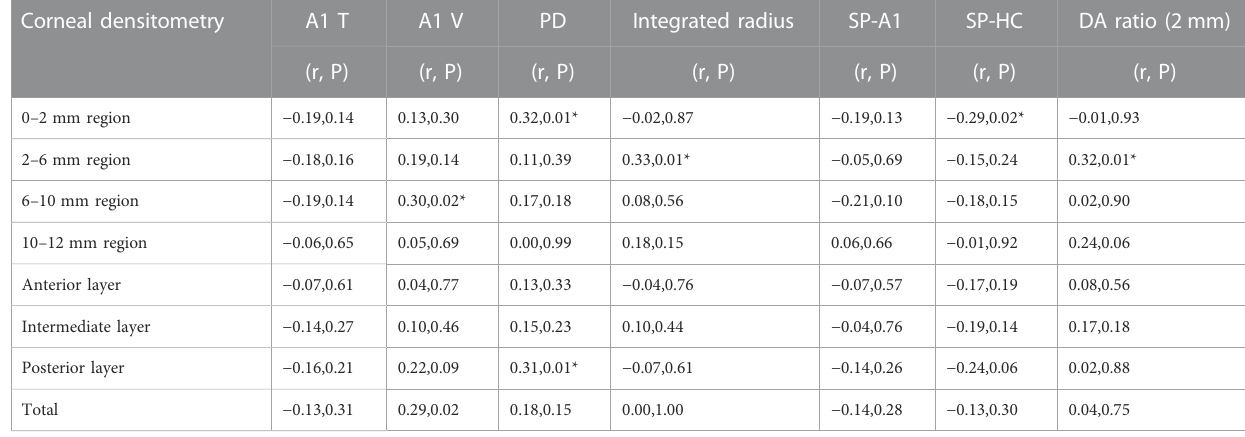
TABLE 4 Correlation analysis between the biomechanical parameters of Corvis ST and the corneal densitometry values. Corneal densitometry